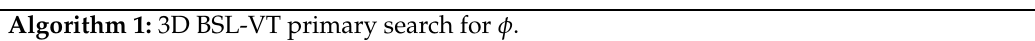
Algorithm 1: 3D BSL-VT primary search for φ